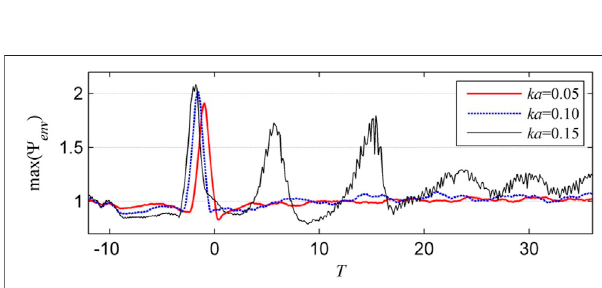
FIGURE 7 | Evolution of the wave maxima in the numerical simulations shown in Figure 6 .